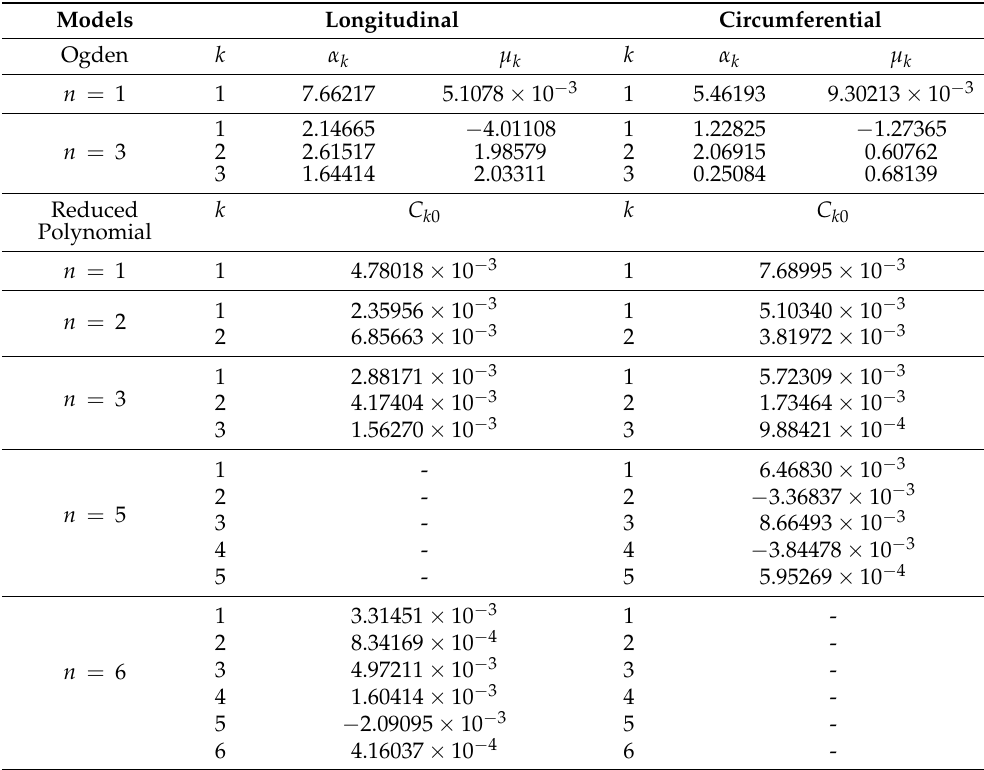
Table 1. Constitutive FEM models considered for this study. Models Longitudinal Circumferential